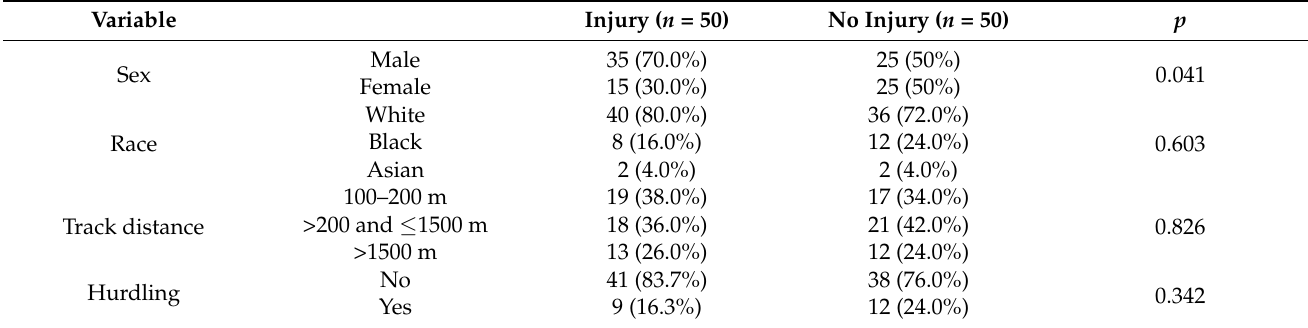
Table 2. Athletes’ sociodemographic characteristics and event type by group, i.e., those with and without a history of injury.